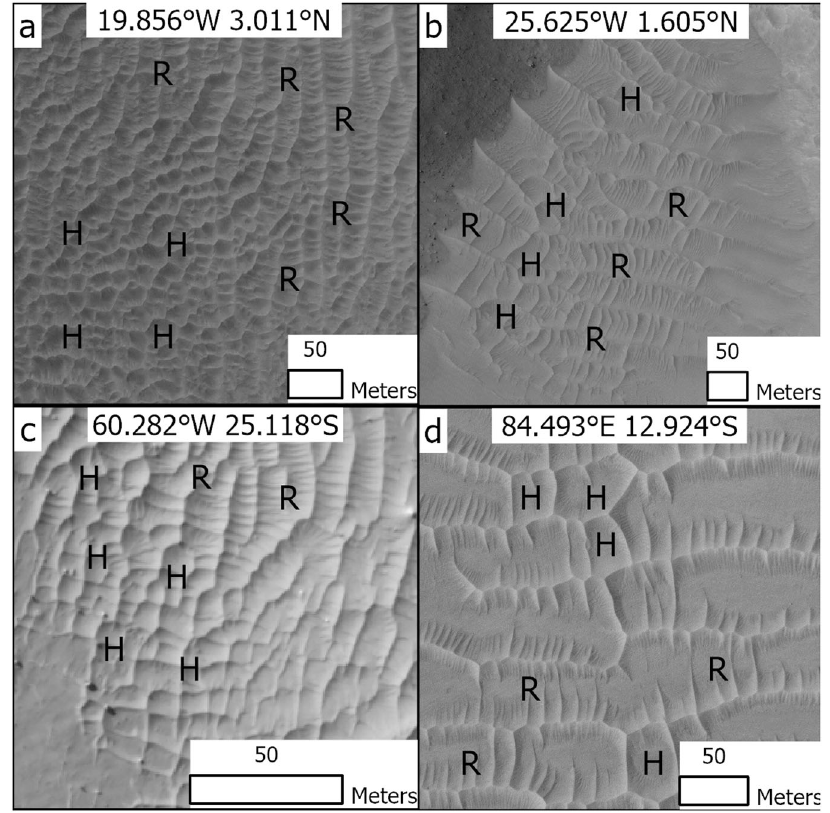
Fig. 3 Spatial relationships between networked TARs. Hexagonal networks (H) are commonly found surrounded by rectangular networks (R) where primary/secondary ridge amplitudes and orientations are still visible ( a ESP_024266_1830, b ESP_027708_1815, c ESP_017661_1545, d